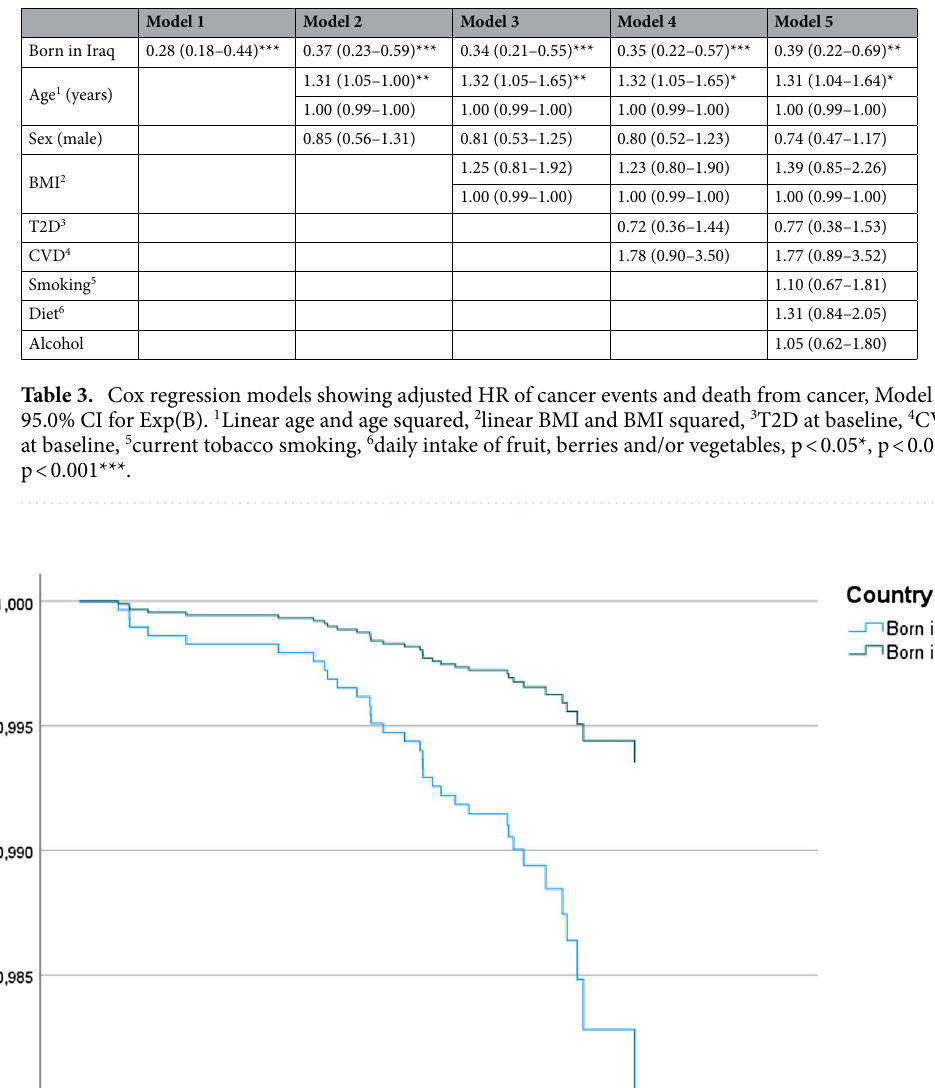
Fig. 4 is defined as CVD (coronary heart disease (angina pectoris and myocardial infarction), cerebrovascular (cerebral infarction, cerebral haemorrhage, transitory ischaemic attack), claudicatio intermittens or CV death. Discussion